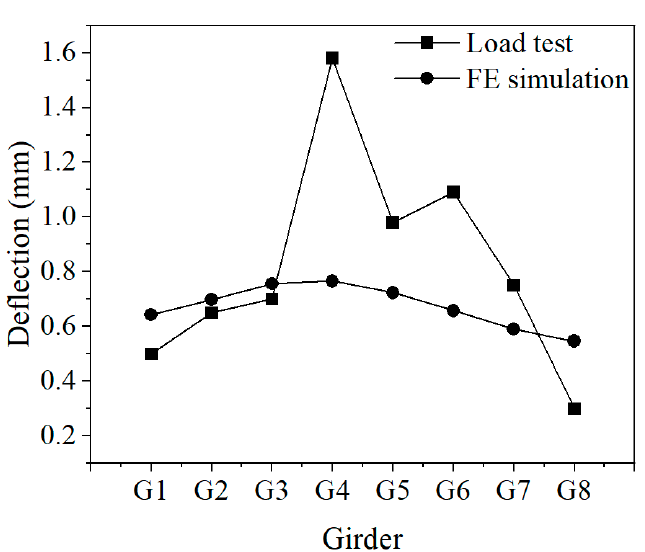
Figure 8. FE model.